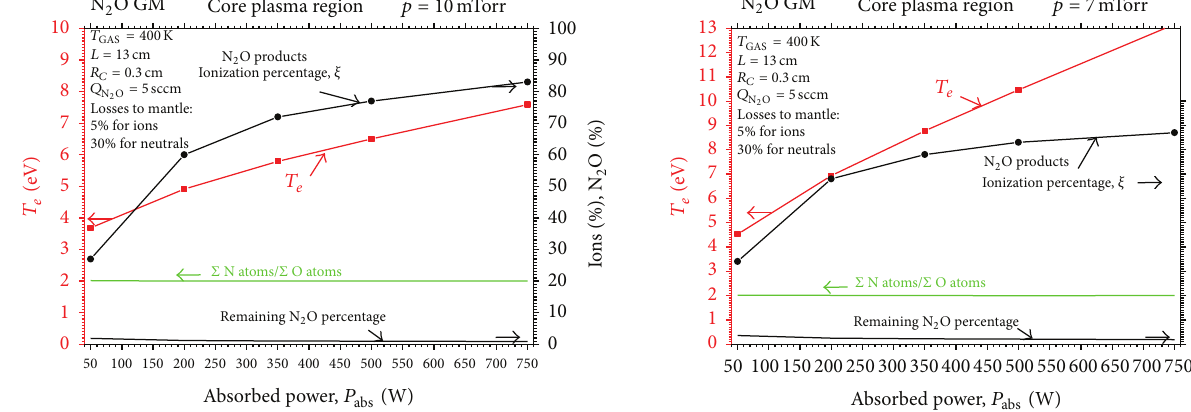
Figure 11: As in Figure 10 but for 𝑇 𝑒 , ionization percentage, and N 2 O remaining percentage.